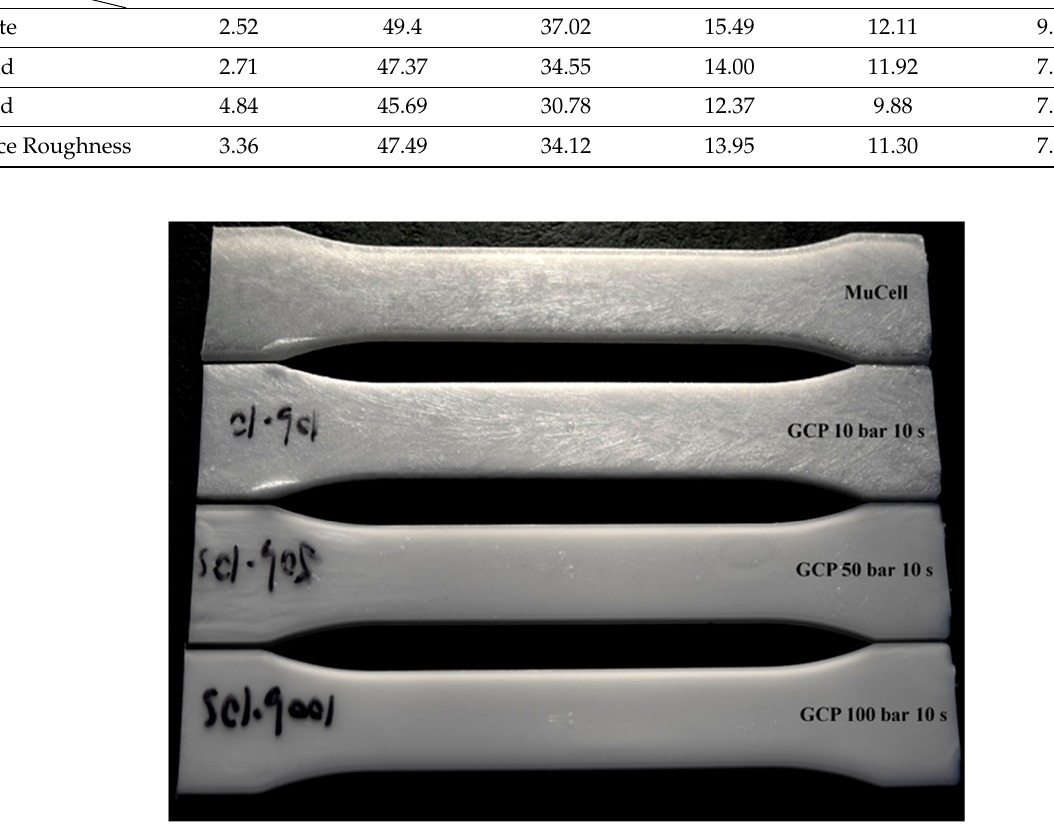
Figure 8. Surface visual quality of the microcellular molded parts at different GCPs.